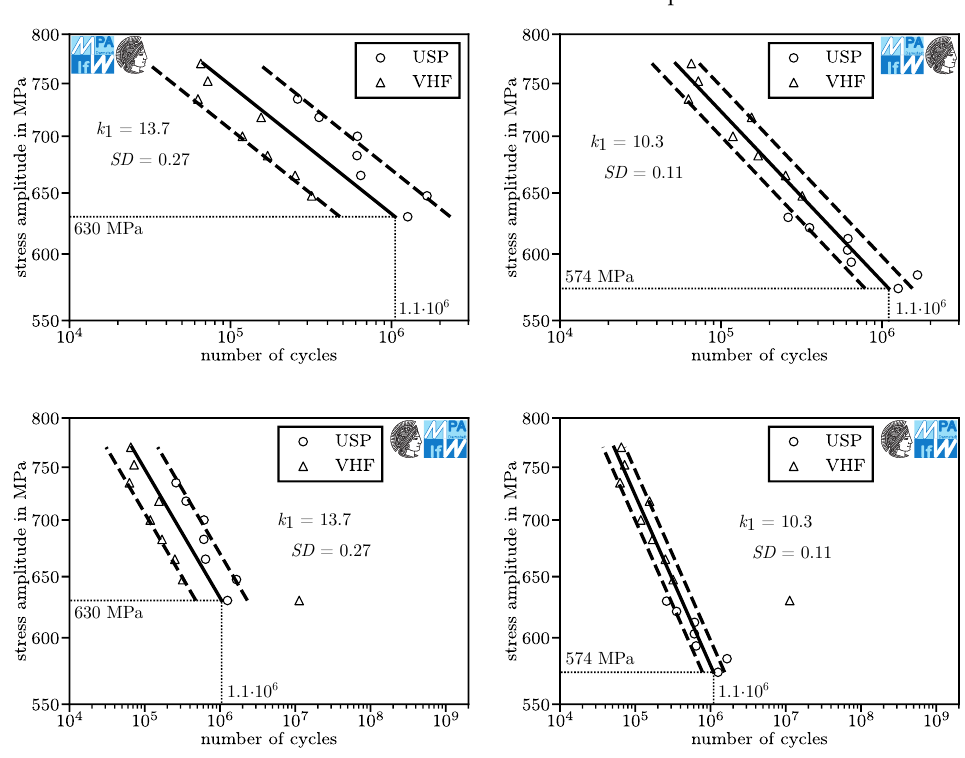
Figure 10. Fatigue behavior of 50CrMo4 in argon; 919MPa ultimate tensile strength; K t = 1.75; Curves of 10, 50 and 90% probability of survival; run-outs are marked with an arrow; left side: before correction; right side: after correction; top: only HCF region; bottom: including VHCF